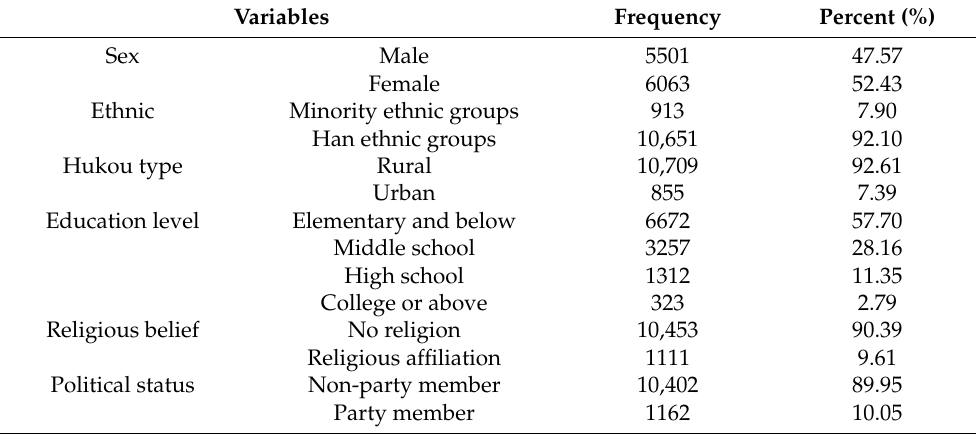
Table 1. The sample distribution of this study (N =